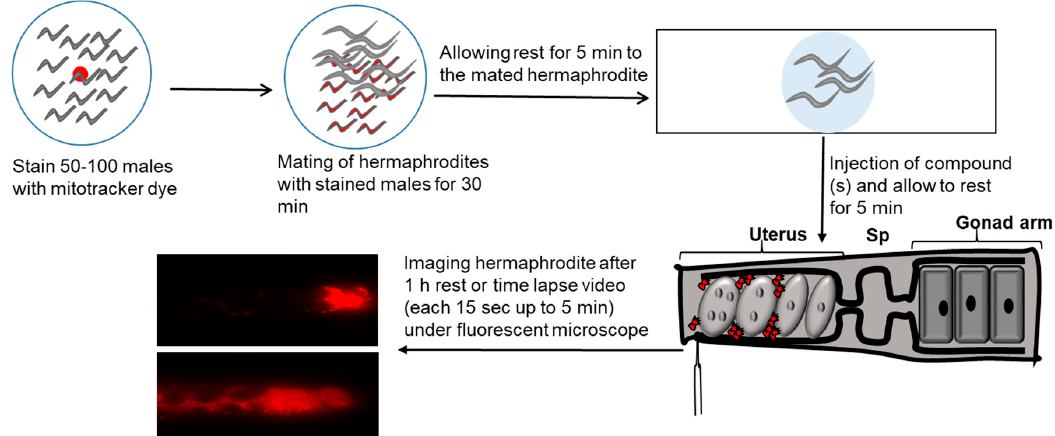
Figure 2. Schematic representation of method of sperm guidance assay used in C. elegans . Male worms incubated with MitoTracker are represented as red. Sperm guidance is evaluated by mating Mito-Tracker labeled males to adult hermaphrodites and accumulation of sperms is measured 1 h after mating in the different zones of uterus. In this assay, sperm distribution is assessed by dividing the uterus into three zones, and counting sperm in each zone. We consider a value < 70% zone 3 targeting and p < 0.001 as biologically significant using a t-test. Sp = spermatheca.